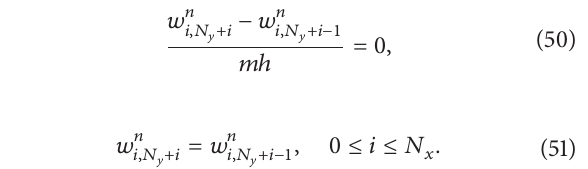
along the side 𝐴𝐵 of the rhomboid. The Neumann boundary conditions are translated by replacing the partial derivatives values for the corresponding finite differences approxima- tions